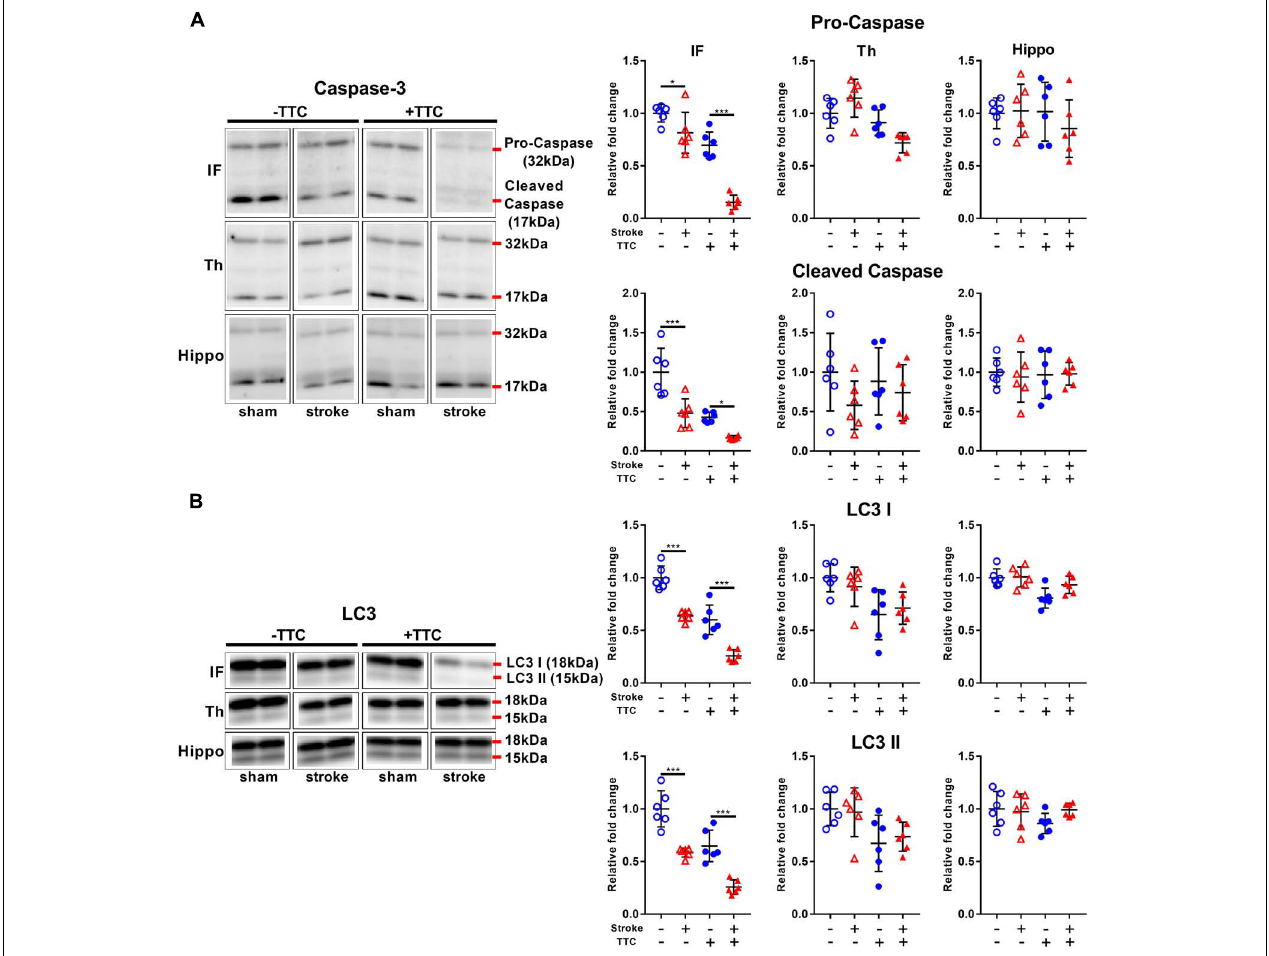
FIGURE 2 | Apoptotic and autophagy markers. Representative western blot and quantification of caspase-3 (pro-caspase and cleaved caspase) (A) and LC3 (LC3I and LC3II) (B) within the infarct (IF), thalamus (Th), and hippocampus (Hippo). Mean ± SEM (two-way ANOVA and Sidak’s multiple